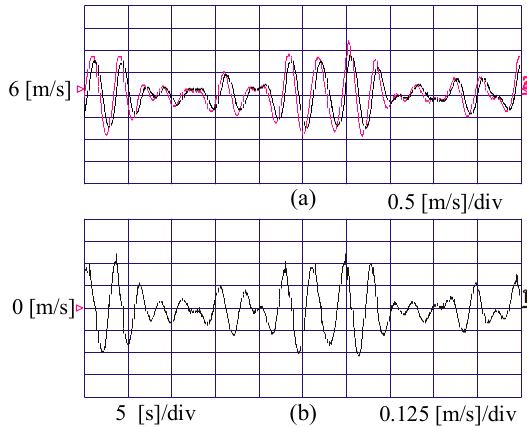
Figure 24. Wind speed estimation accuracy: ( a ) Real and estimated wind speed and ( b ) estimation error.